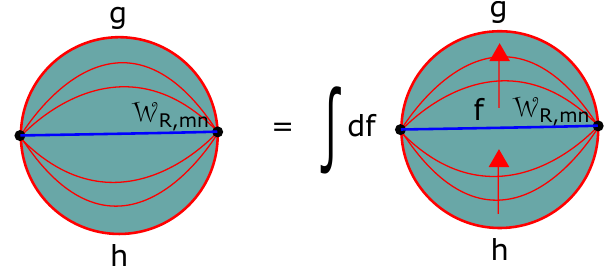
Figure 6 . Left: disk with a single Wilson line inserted. Red lines are Hilbert space slicings. Right: computation done by splitting the disk into two semidisks with the Wilson line in the